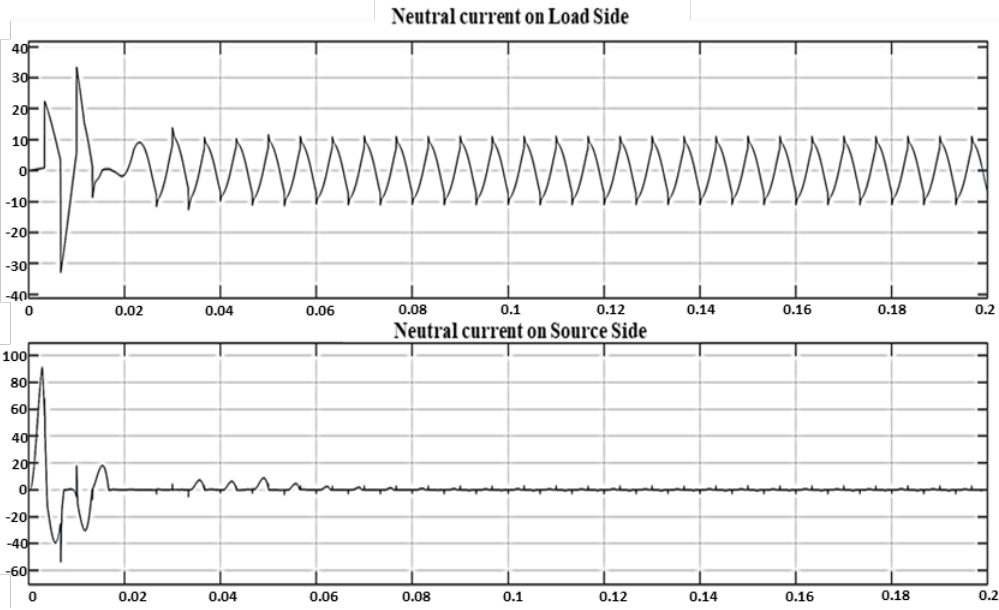
Figure 37. Neutral Line Current with ANN Based Filter In HIL Topology.